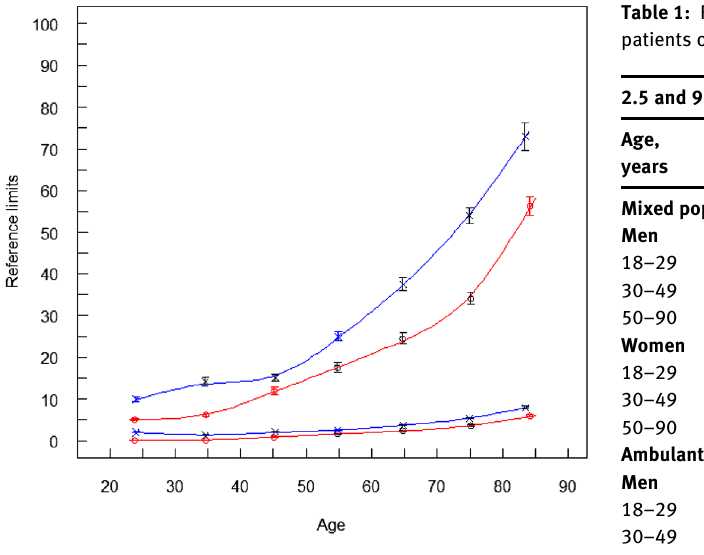
Figure 1: Dependency of age (years) on reference limits (RLs) (ng/L) of high-sensitive cardiac troponin T (red, female patients n=32,411); blue, male patients n=44,347) in a mixed subpopulation (out-patients + in-patients). The upper curves are upper reference limits (uRLs) (97.5th percentiles), and the lower curves are lower RLs (2.5th percentiles) with vertical confidence limits.